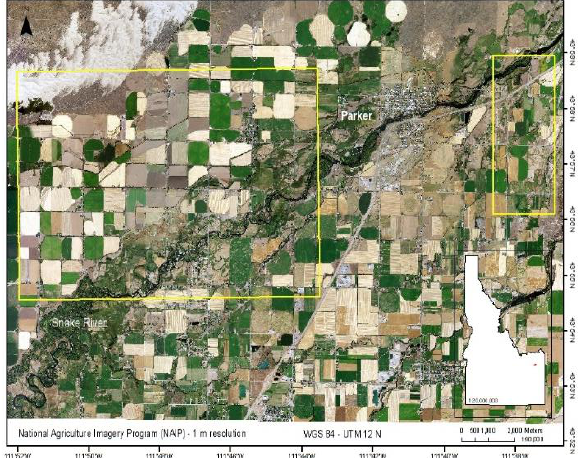
Figure 1. Idaho study area showing field locations near Parker, Idaho. (WGS 84 - UTM 12N)